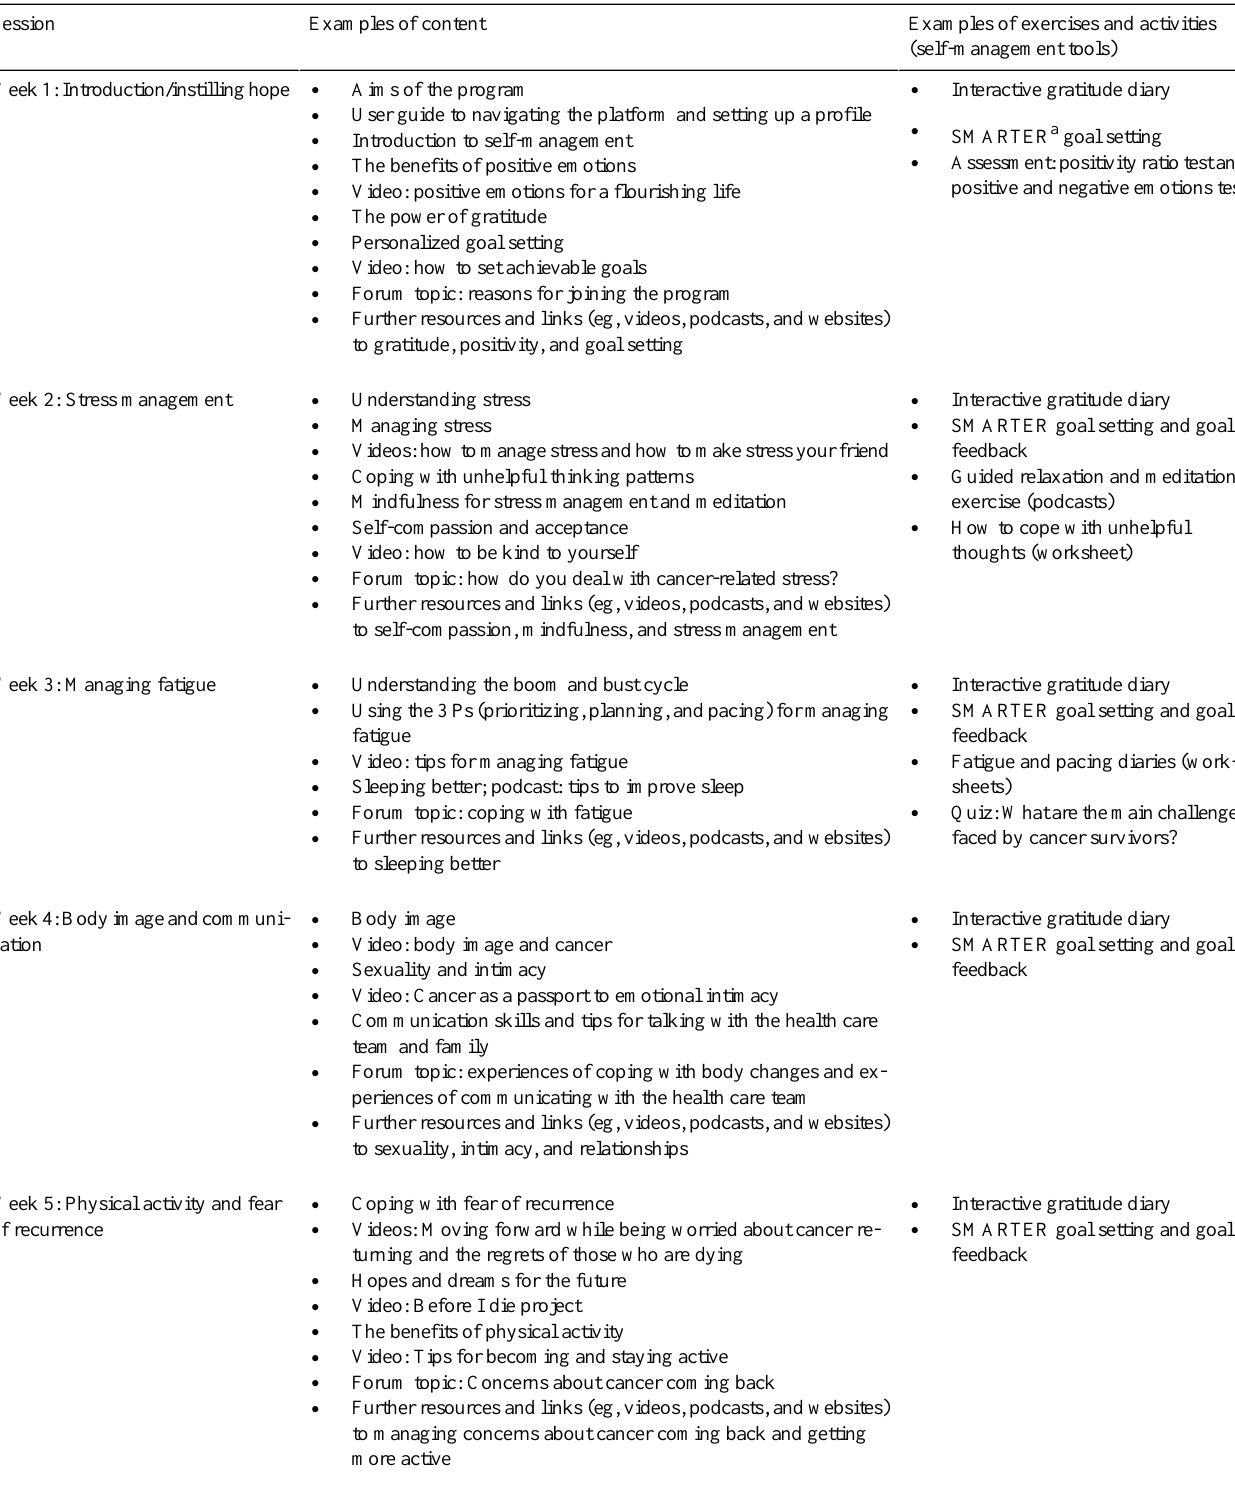
Table 1. Weekly topics, content, exercises, and activities included in the 6-week Help to Overcome Problems Effectively (where ‘i’ indicates digital version)